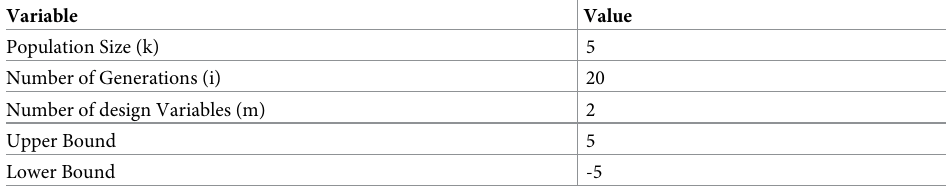
Table 2. Data and Parameters Selection of Jaya